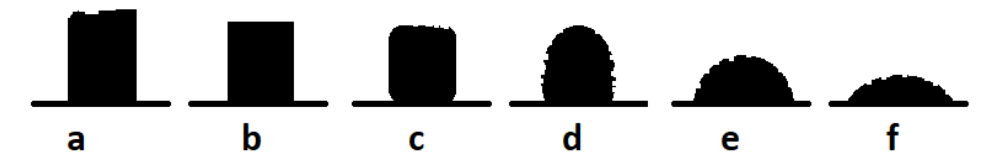
Figure 1. Shape changes of the sample during measurements with the heating microscope. ( a ) starting shape; ( b ) deformation temperature; ( c ) softening temperature; ( d ) sphere temperature; ( e ) hemisphere temperature; ( f ) flow temperature [43].